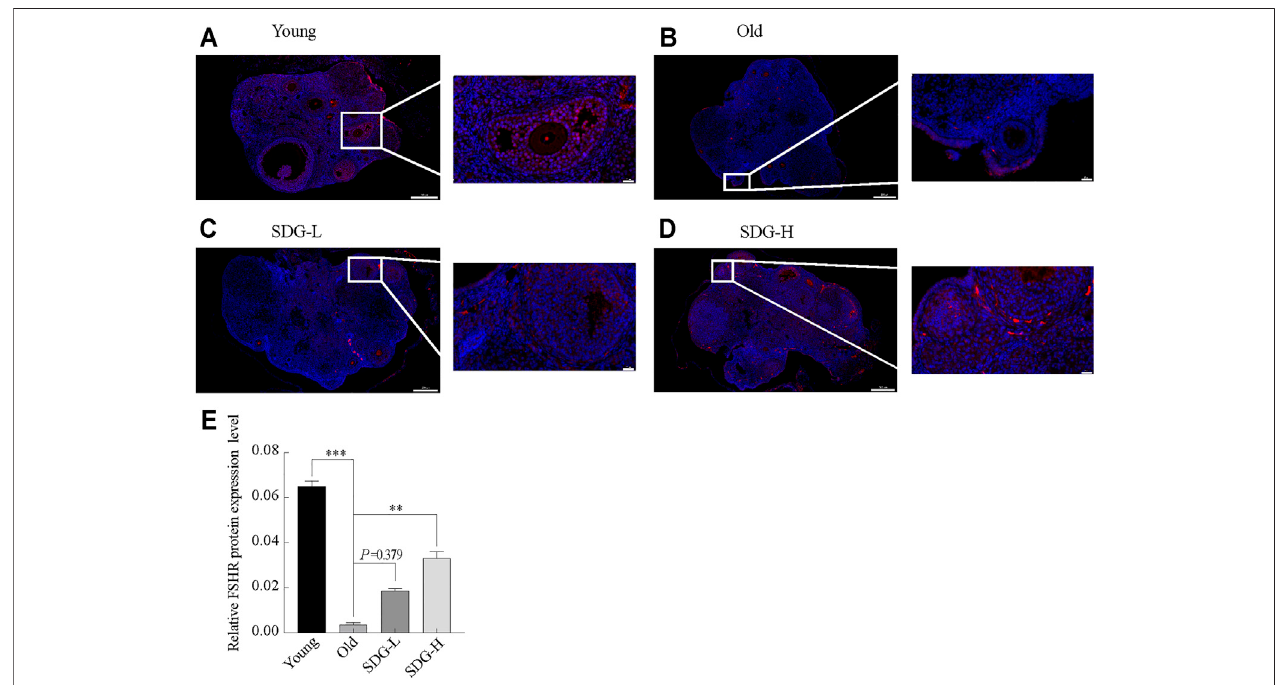
FIGURE 3 | Immuno fl uorescence staining of FSHR protein in the ovaries of mice after intragastric administration of SDG. (A – D) Images of immuno fl uorescence staining of FSHR protein in the ovaries of each group of mice, the Young (A) , the Old (B) , the SDG-L (C) , and the SDG-H (D) . Scale bar, 200 and 20 µm respectively. FSHR protein was detected by a fl uorescein-tagged antibody (Red), and nuclei were stained by DAPI dye (Blue). (E) The comparison of fl uorescence intensity of FSHR protein in ovary sections in different groups. The data are expressed as mean ± SEM. * P < 0.05, ** P < 0.01, *** P < 0.001. The P value is labeled if P > 0.05.